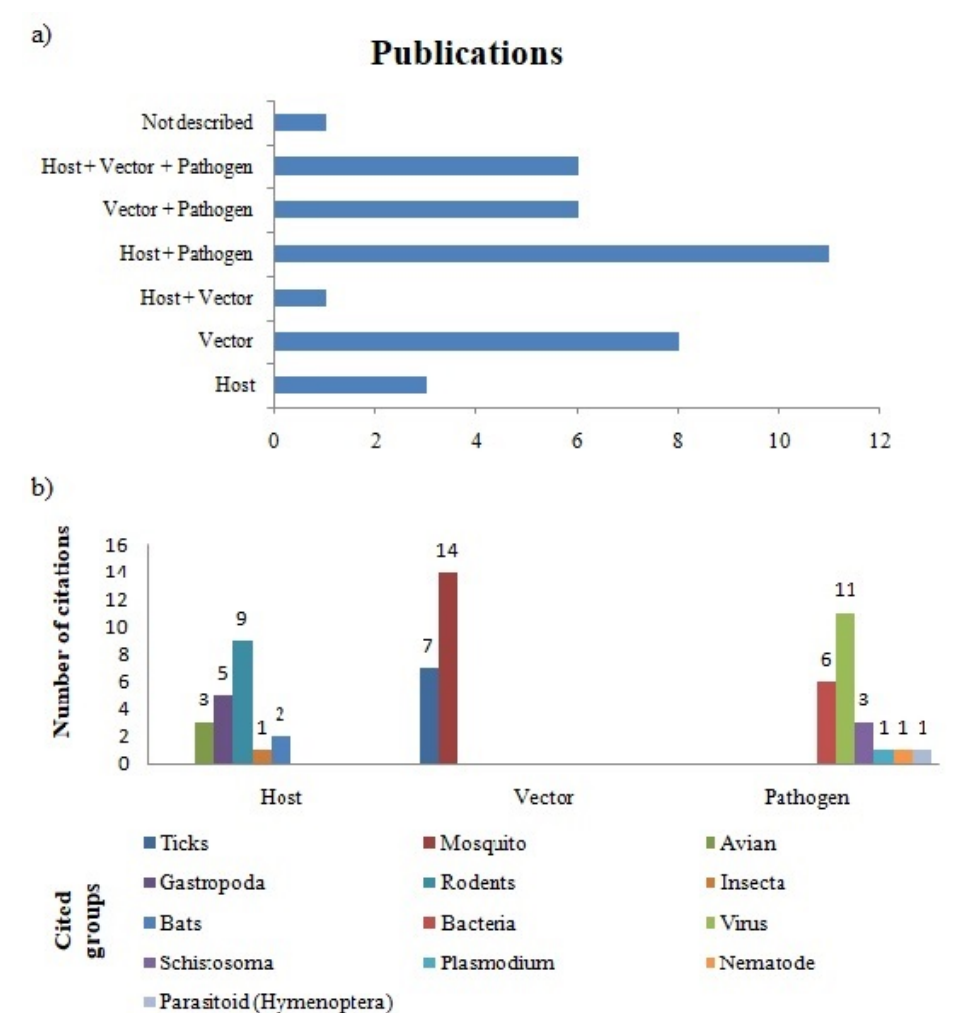
Figure 4. Proportion of biological agents involved in disease dissemination (ordered, in this study, in “risk attributes” parameter) and how they were handled by authors: ( a ) frequency in which each type of interaction between agents leading to the occurrence of disease was evidenced in the dataset; ( b ) taxonomic groups more assigned for each category (host, vector, and